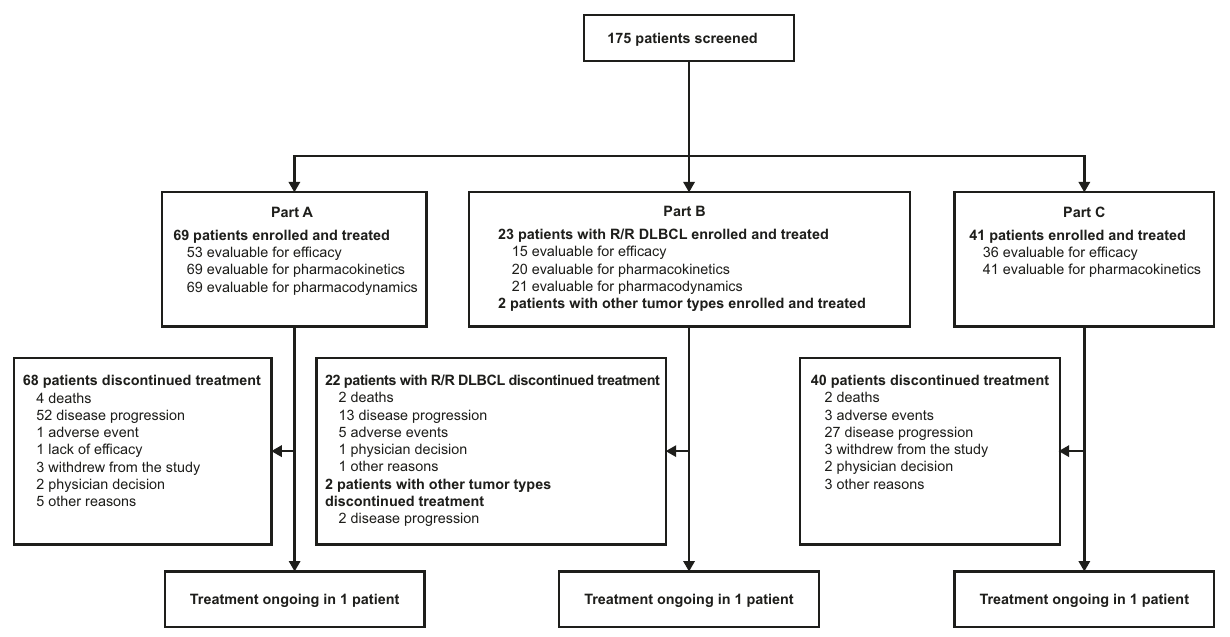
Fig. 1 | Patient disposition as of June 16, 2022. DLBCL diffuse large B-cell lymphoma, R/R